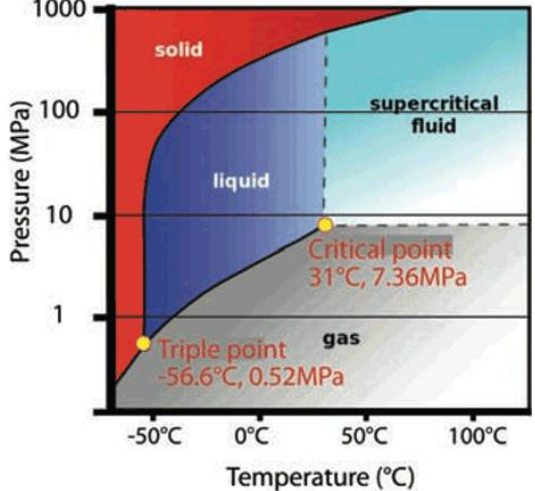
Figure 16. The phase diagram of CO 2 (date were obtained from REFPROP Database [38]).